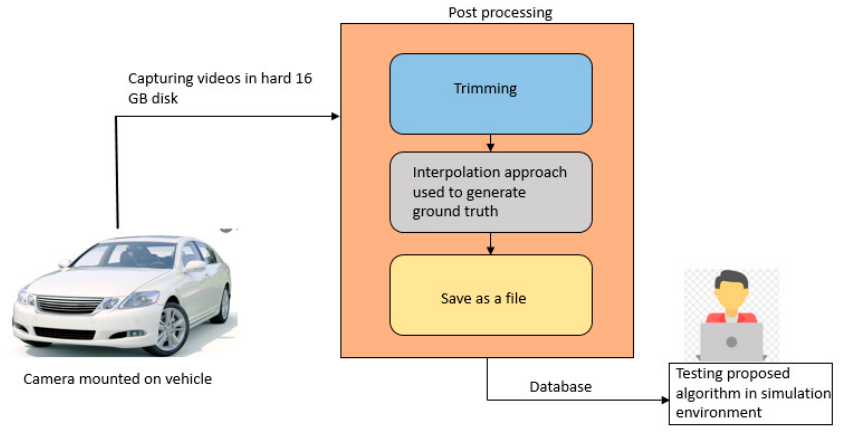
Figure 2. Summary of the procedure adopted to develop ground truth data.